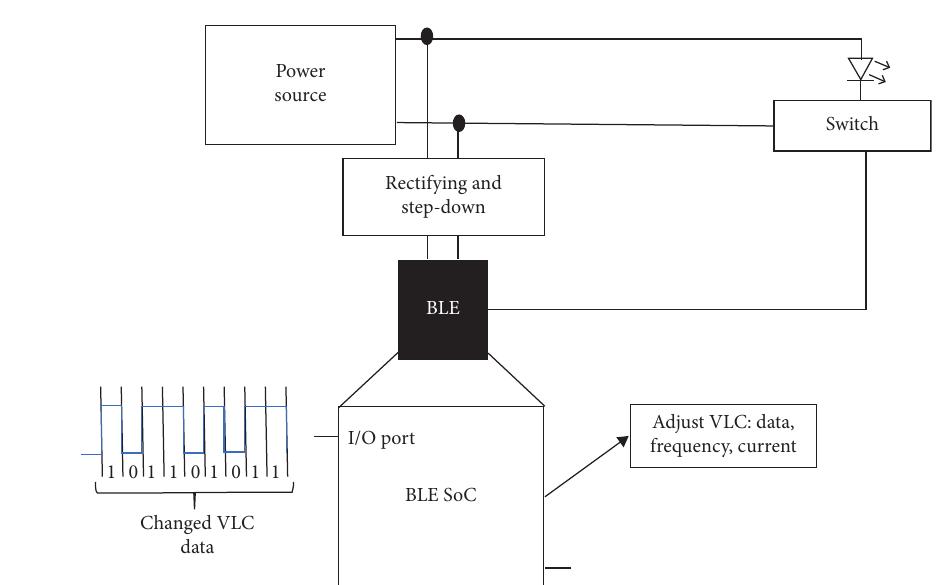
Figure 2: Block diagram of LED